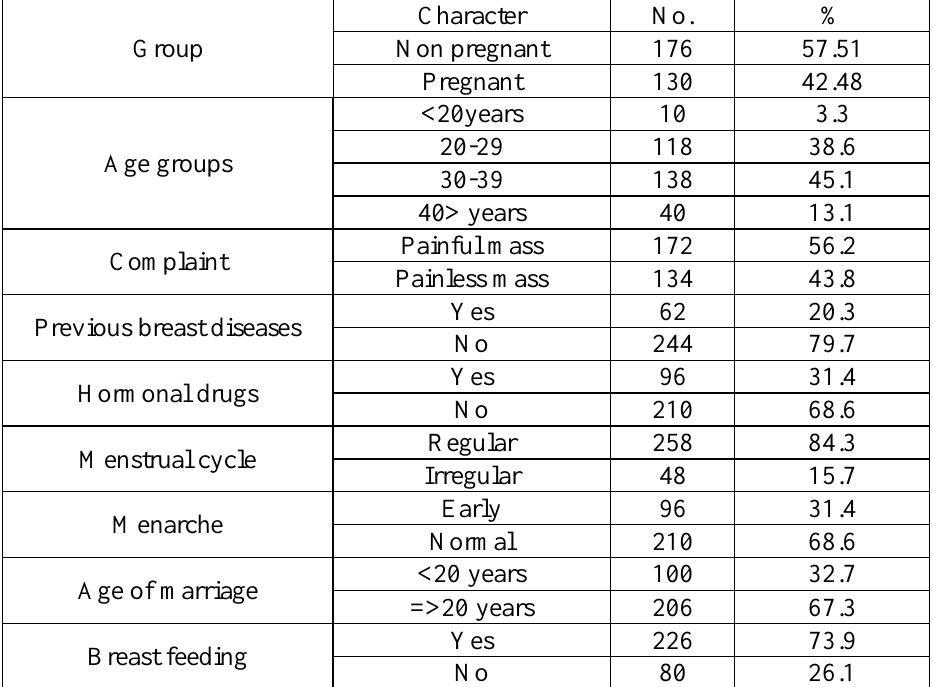
Table 1: Distribution of patients according to studied variables